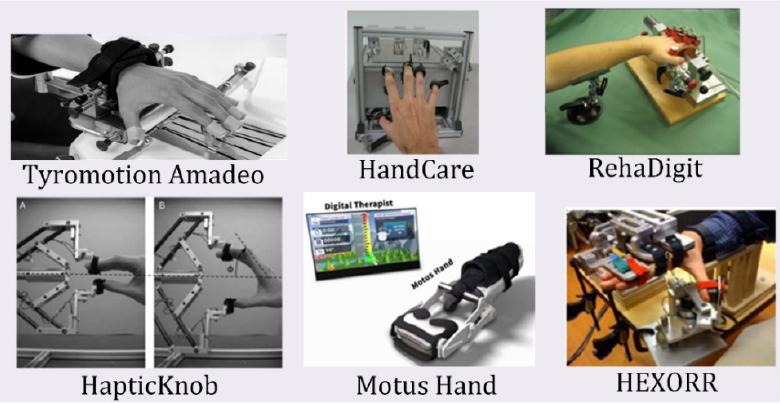
Figure 8. End-effector devices are reviewed in this paper. These devices use end-point control to actuate the hand for proper rehabilitation.